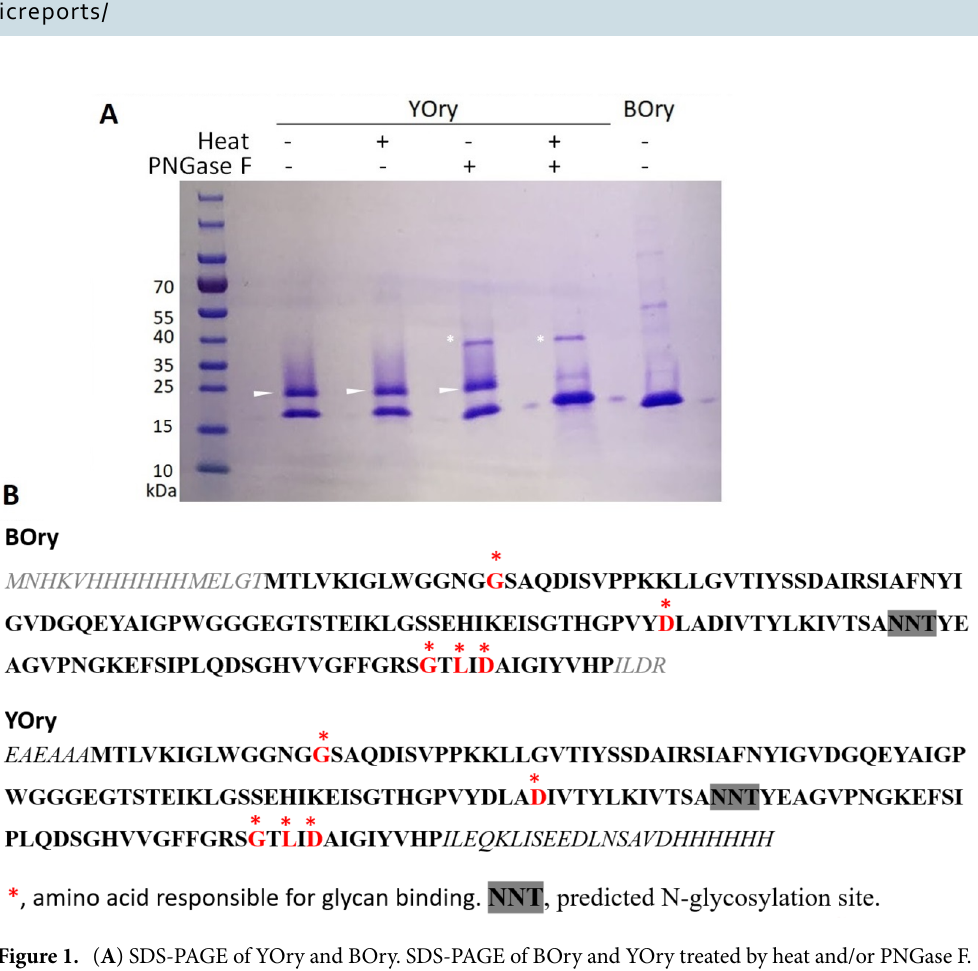
Figure 1. ( A ) SDS-PAGE of YOry and BOry. SDS-PAGE of BOry and YOry treated by heat and/or PNGase F. Orysata was inactivated by heating in 100 µl of PBS for 1 h at 98 °C. For the PNGaseF treatment, Orysata was diluted in PBS for 1 h at 98 °C, and then, 3 µl of PNGaseF (Promega) was added and incubated for 12 h at 37 °C. For the control, YOry was not heated but incubated with PNGase F. White arrows indicate the N-glycosylated YOry. * indicates the position of PNGase F on the gel. ( B ) Protein sequences for both BOry and